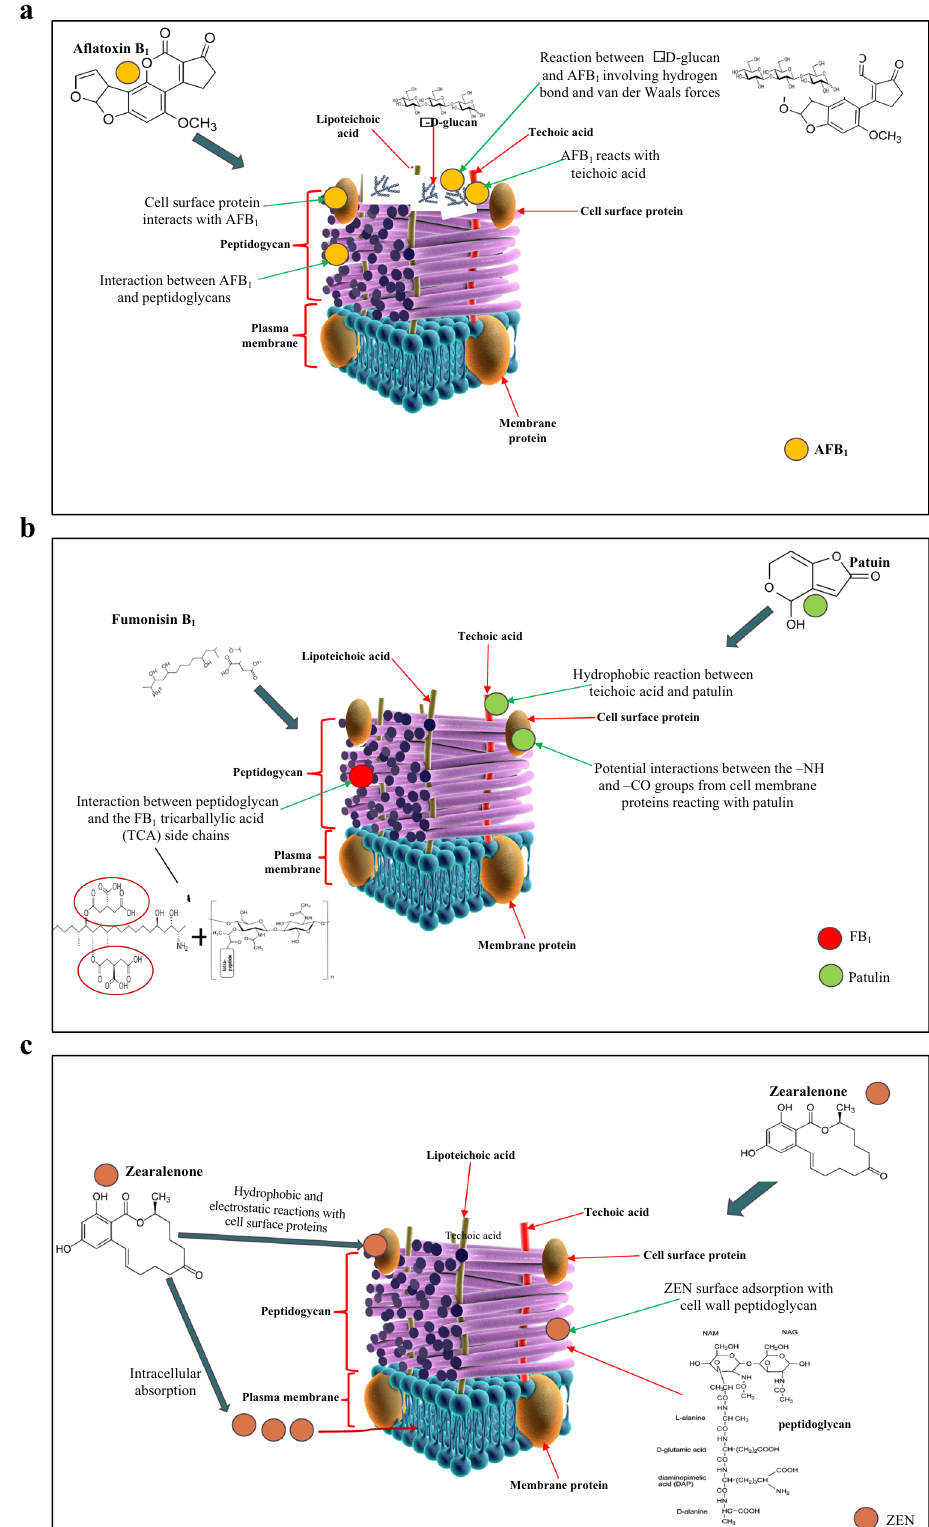
Potential interactions between the –NH and –CO groups from cell membrane proteins reacting with